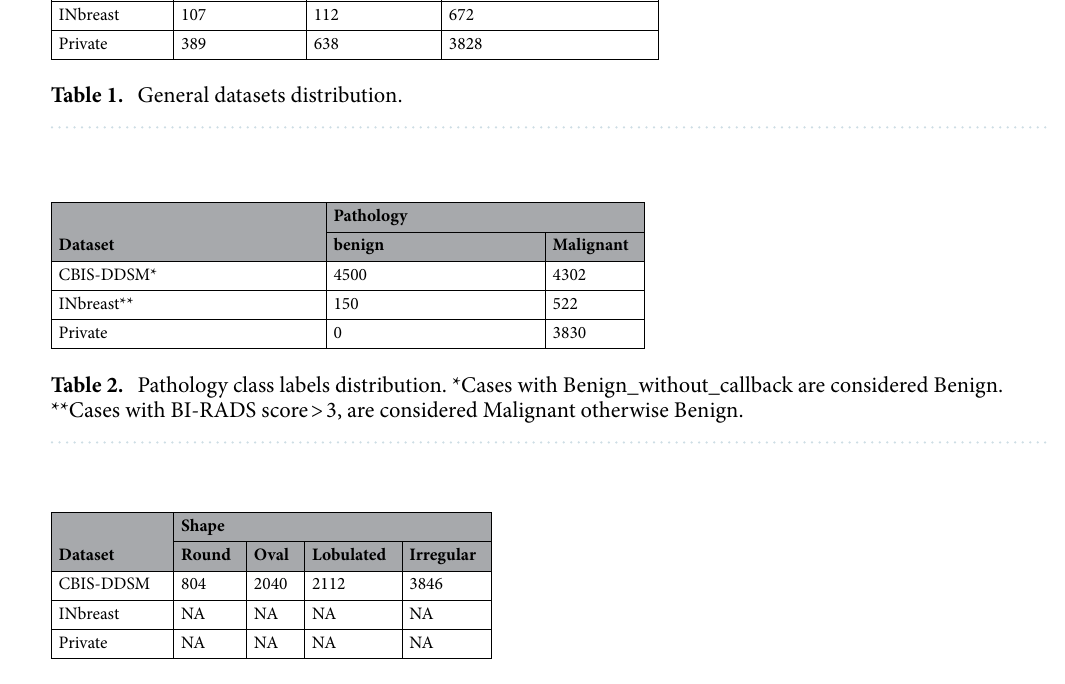
Table 3. Shape class labels distribution.